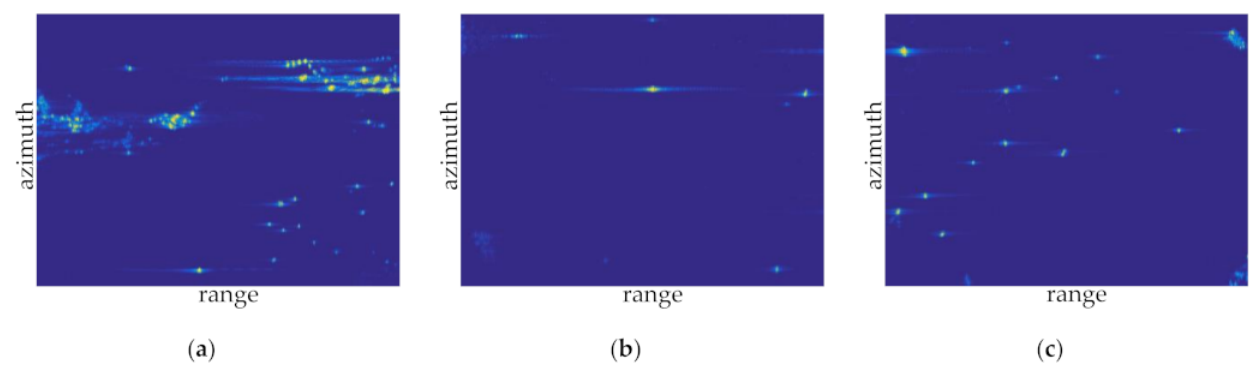
Figure 13. Image samples in offshore water: ( a ) sample 1; ( b ) sample 2; and ( c ) sample